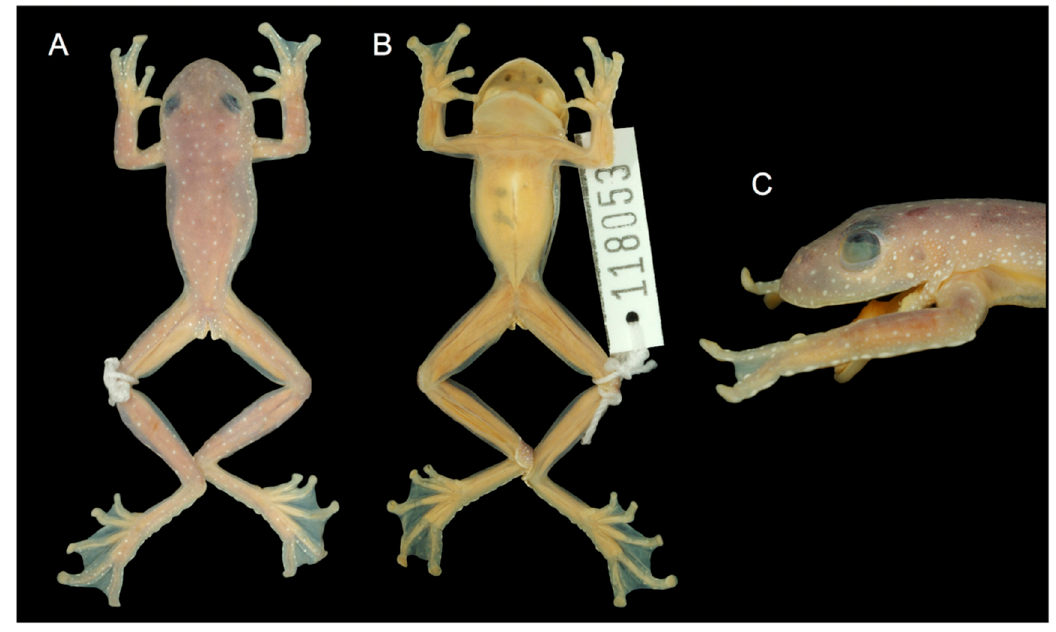
Figure 81. Cochranella resplendens in preservative. Holotype (KU 118053) from Santa Cecilia, Sucumbíos province, Ecuador. ( A ) Dorsal view. ( B ) Ventral view. ( C ) Lateral view. Photos by Martín Bustamante.